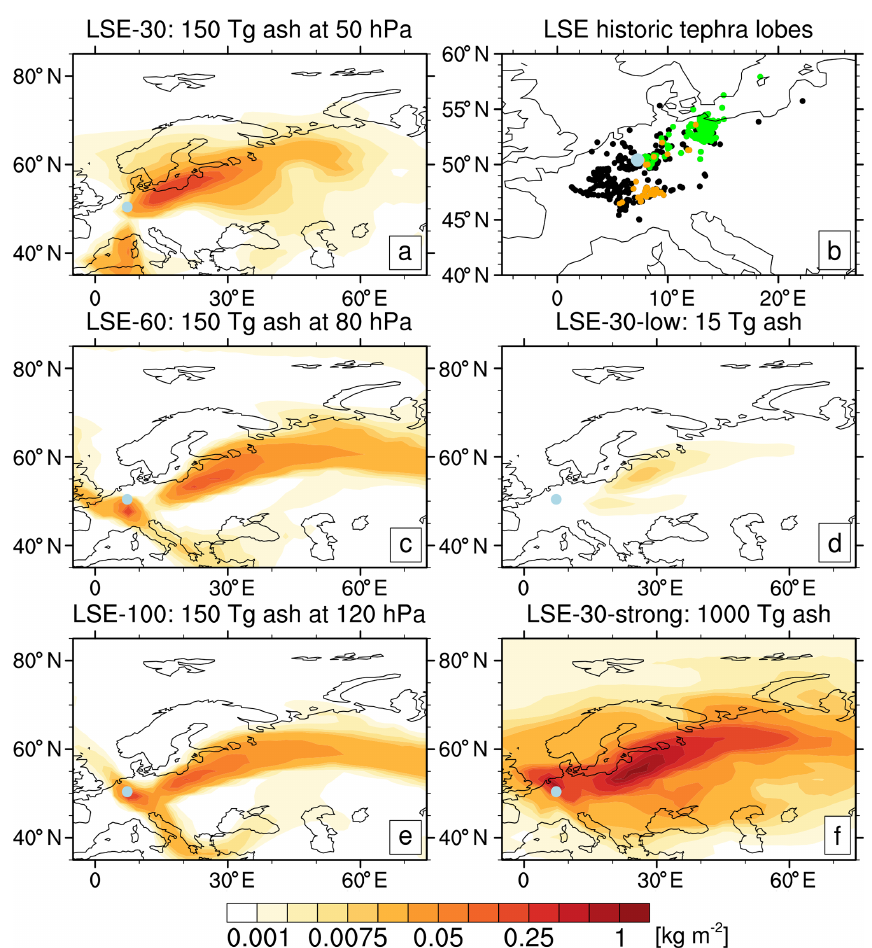
Figure 3. Deposition of fallout ash accumulated over May and June following the explosive eruption phases in simulations LSE-30 to LSE- 30-strong. Simulations with injection of 150Tg fine ash at different altitudes (a, c, e) , simulations with two different injection rates, both at 50hPa for the fine ash (d, f) , and (b) currently known distribution of all Late Pleistocene tephra deposits (black) of the LSE; LLST is in green, and MLST is in orange (Riede et al., 2011; Reinig et al., 2020). Note that many LST finds are not directly associated with any specific eruption phase. The light blue dot marks the eruptive